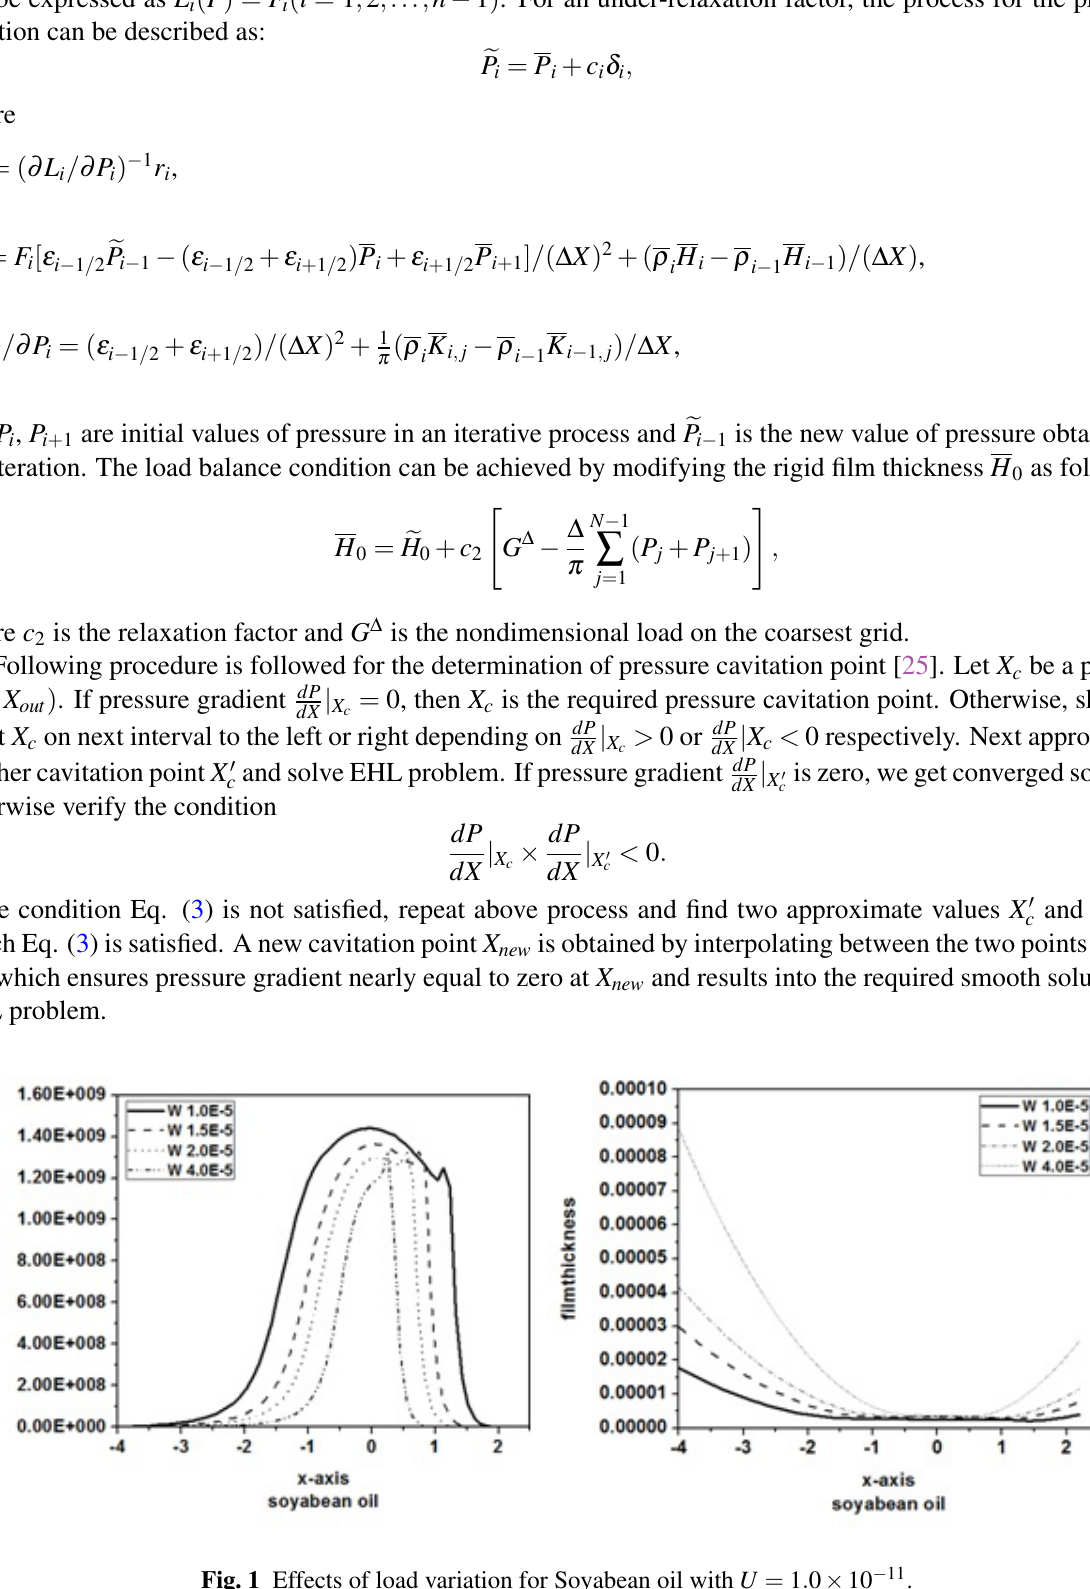
Fig. 1 Effects of load variation for Soyabean oil with U = 1 . 0 × 10 − 11